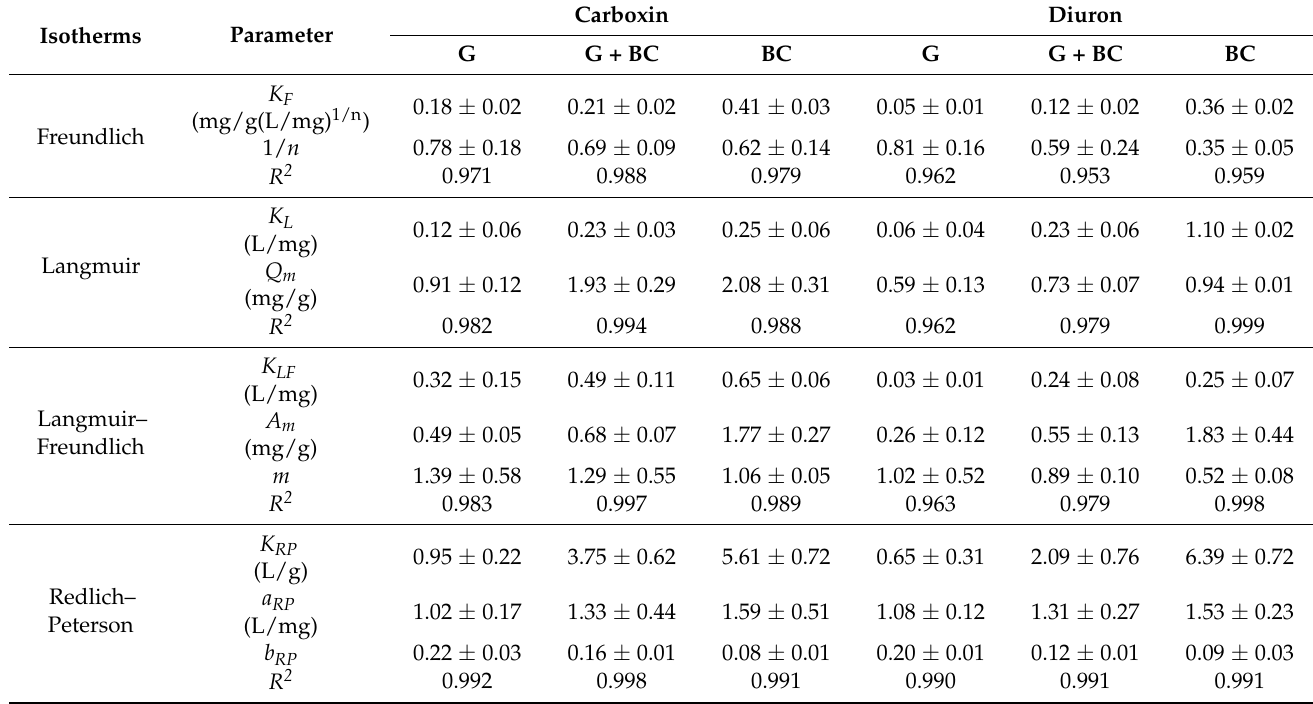
Table 4. Isotherm parameters of pesticides adsorption on the goethite (G), biochar (B) and goethite–biochar mixture (G+BC). Isotherms